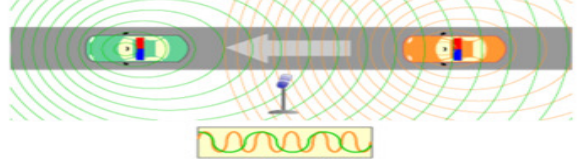
Figure. 3 . Description of the Doppler effect is obtained at the microphone for two waves approach each sources.